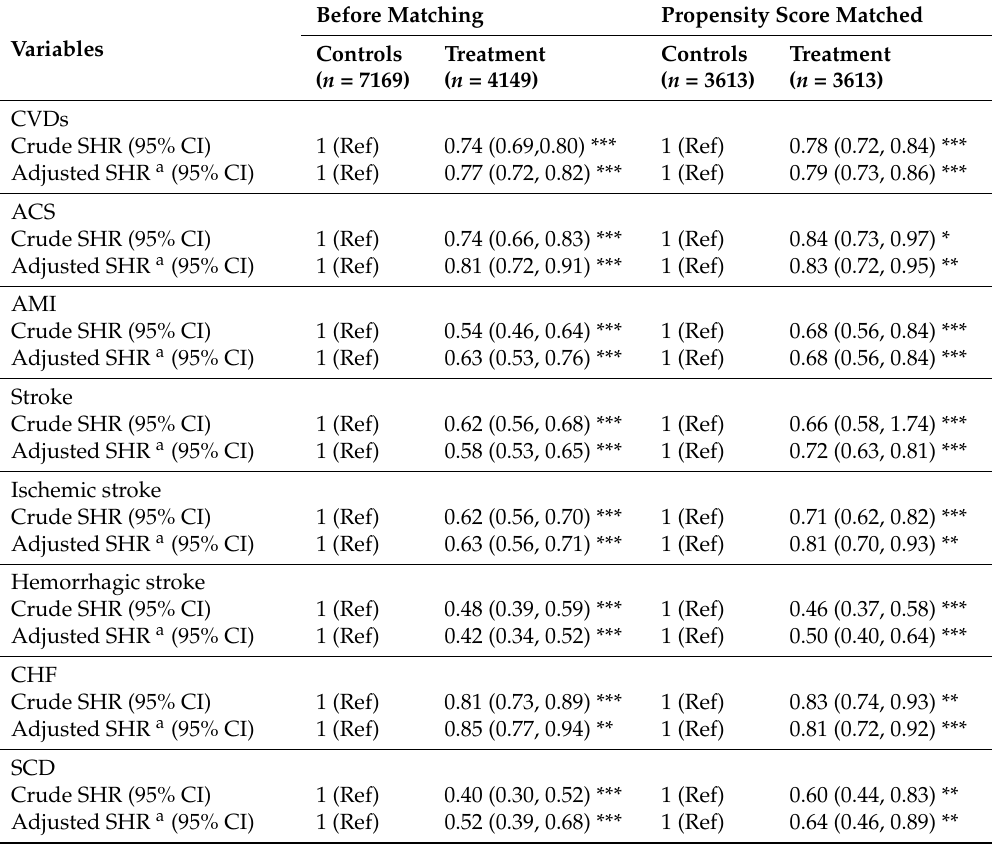
Table 3. Competing risk (death) model-measured subhazard ratios (SHRs) of outcomes with and without propensity score matching between